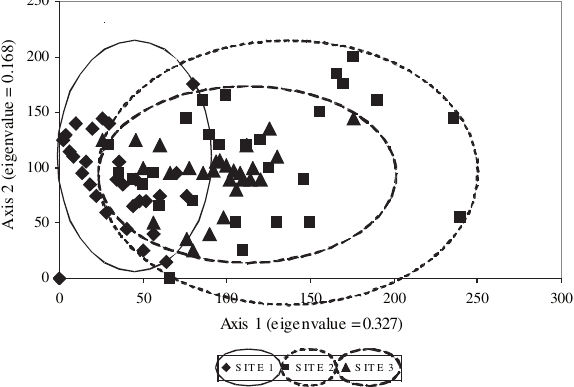
Fig . 3. – Comparison of the three sampled sites during 1994-1996 Fig . 4. – Mean abundance of lugworms Arenicola marina at Culbin for benthic macrofauna at Culbin Sands lagoon, NE Scotland (test: Sands lagoon, NE Scotland, in winter and summer, at the three sam- DECORANA, only values along the two main eigenvalues were pled sites (P<0.01 between seasons in 1995, and between seasons plotted). and sites in 1996; test: TWO-WAY-ANOVA).